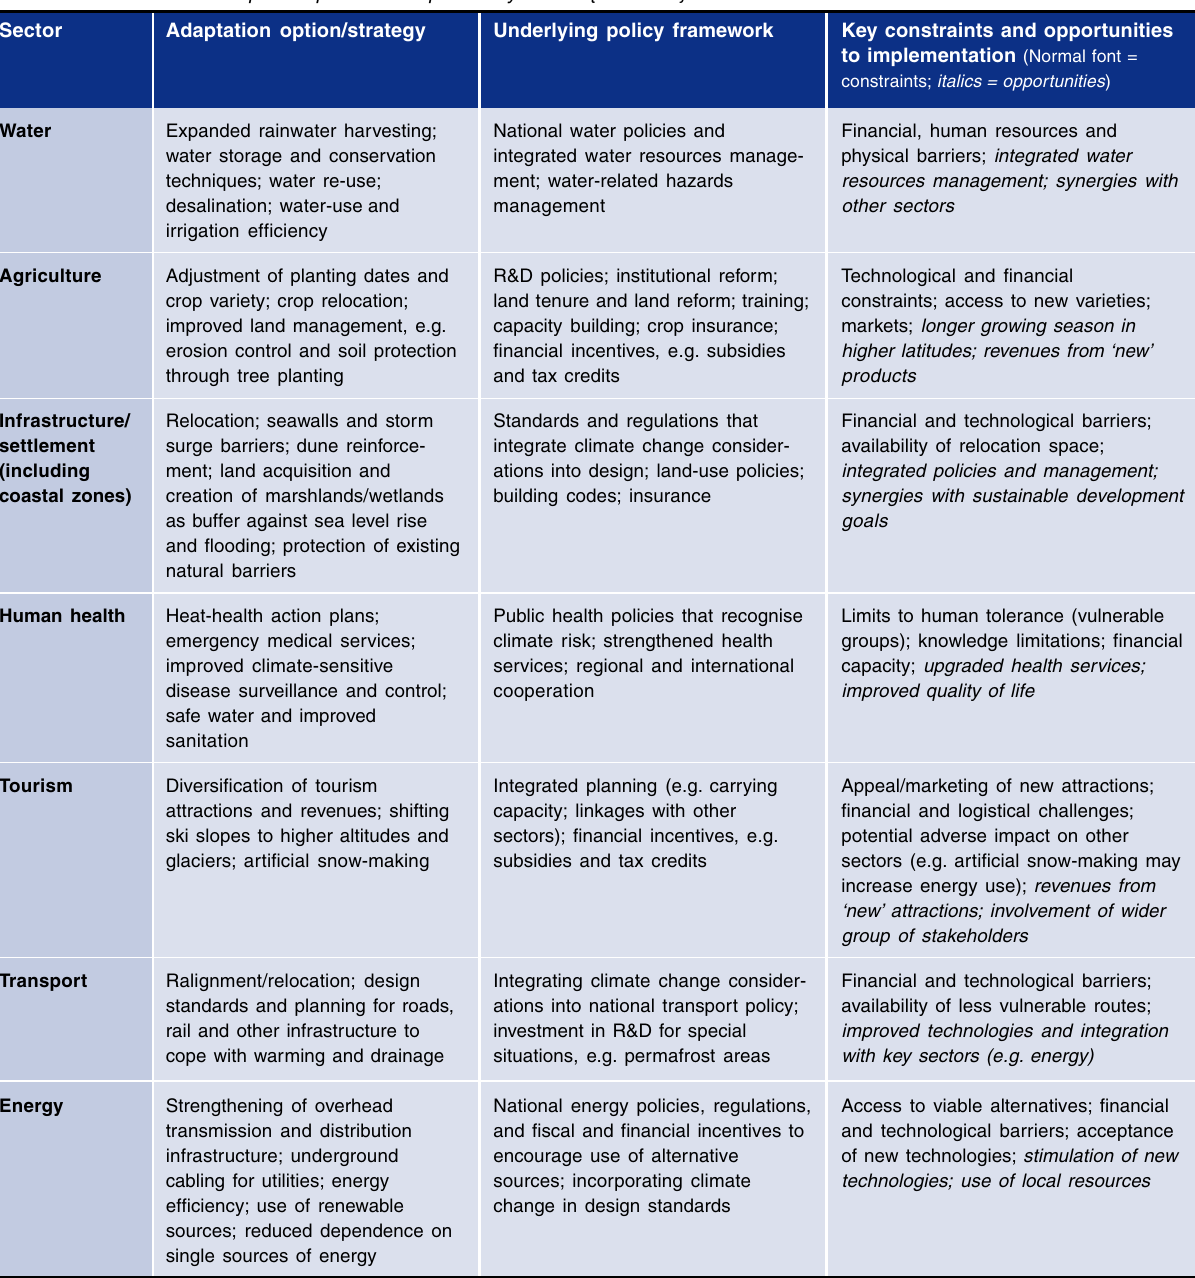
Table SPM.4. Selected examples of planned adaptation by sector. {Table